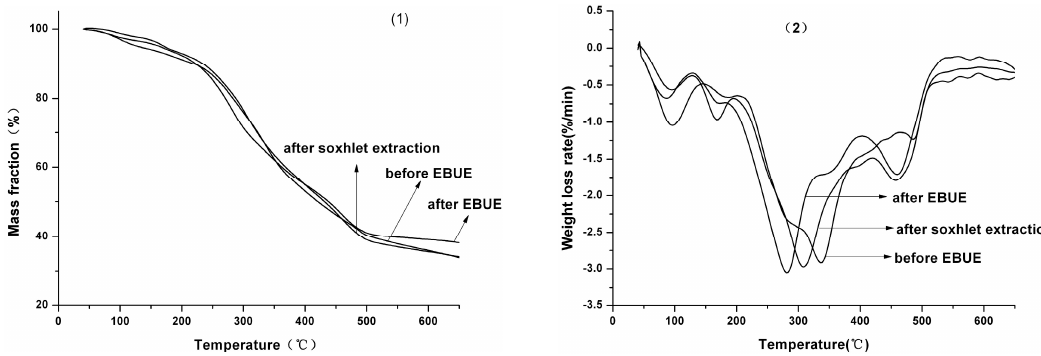
Figure 2. TG ( 1 ) and DTG ( 2 ) curves of GBL before and after EBUE as well as Soxhlet extraction. Table 3. Characteristic parameters in thermal decomposition of GBL before and after EBUE as well as Soxhlet extraction.